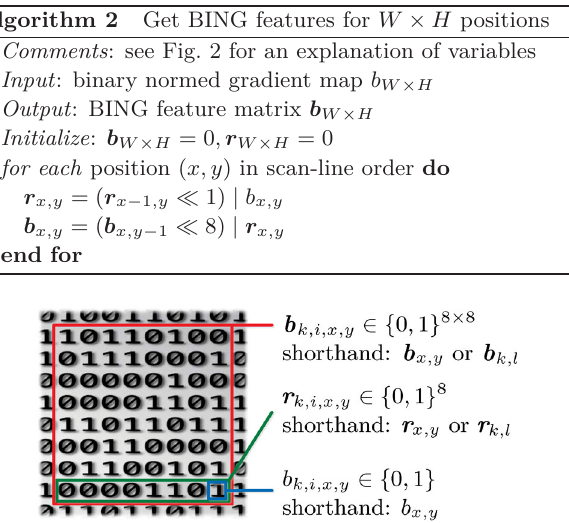
Fig. 2 Variables: a BING feature b x,y , its last row r x,y , and last element b x,y . Notice that the subscripts i,x,y,l,k , introduced in Eq. (2) and Eq. (5), are locations of the whole vector rather than the indices of vector elements. We can use a single atomic variable ( int64 and byte ) to represent a BING feature and its last row, respectively, enabling efficient feature